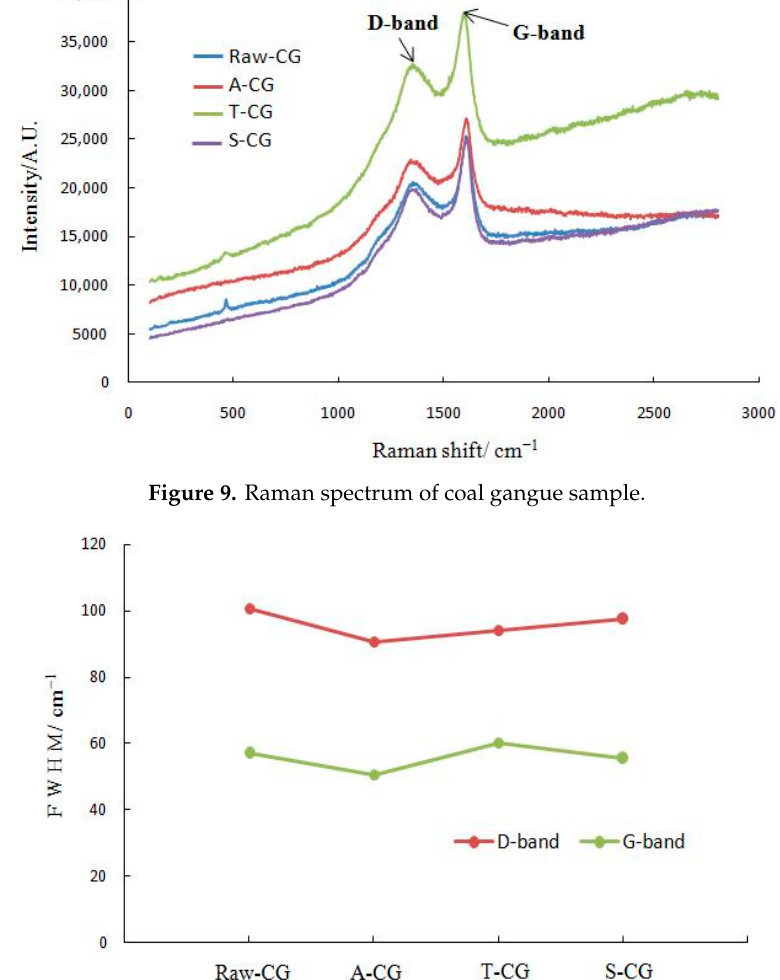
Figure 10. The half-height and width charts of the Raman peak ( FWHM) of coal gangue.